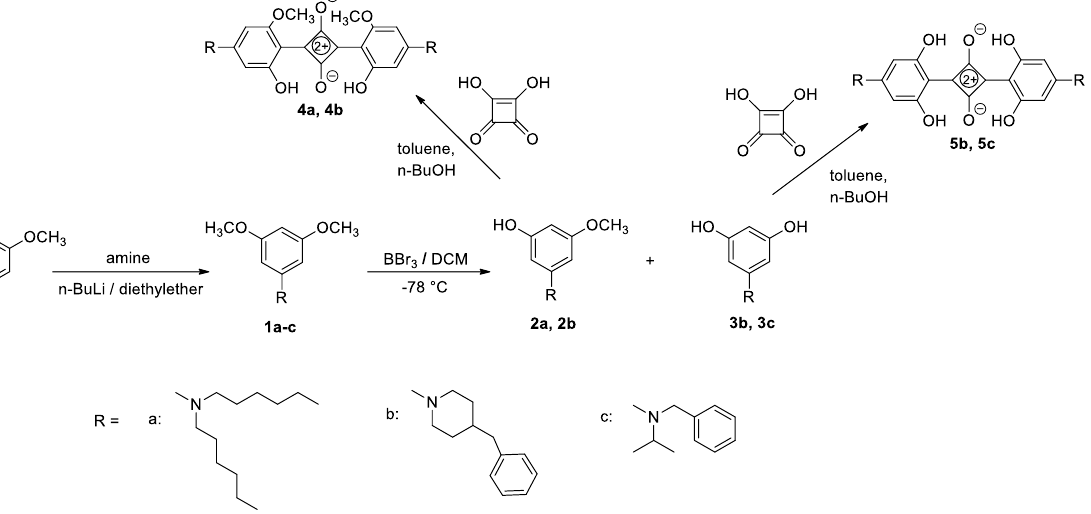
Figure 5. Synthesis of squaraines 4a , 4b , 5b and 5c .